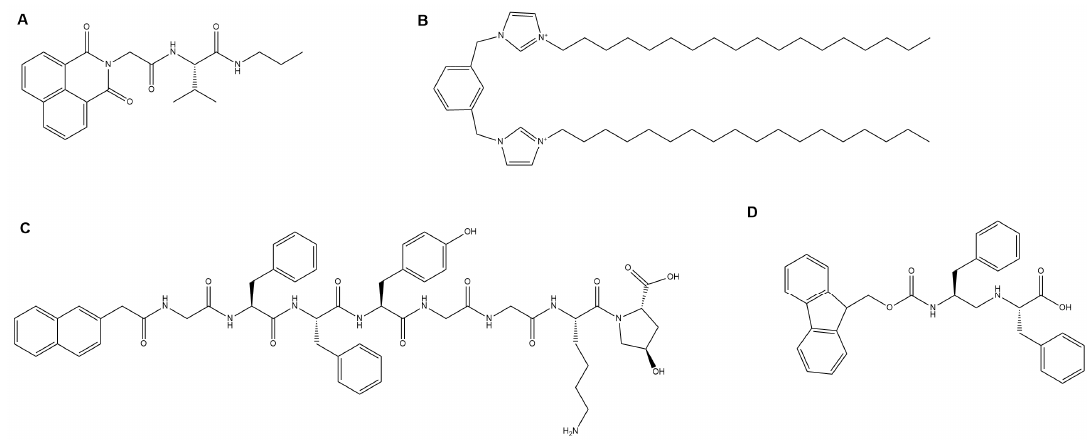
Figure 9. Selected gelators developed for biomedical applications: ( A ) a gelator derived on a 1,8-naphthalimide unit linked to a dipeptidic glycine-valine unit with demonstrated facile transport into human carcinoma cells for oral drug delivery [89]; ( B ) a gemini imidazolium amphiphile gelator for topical drug delivery [90]; ( C ) a collagen-inspired hydrogelator for tissue engineering [91]; and ( D ) an aromatic di-phenylalanine-based gelator silver-based antimicrobial wound treatment [92].